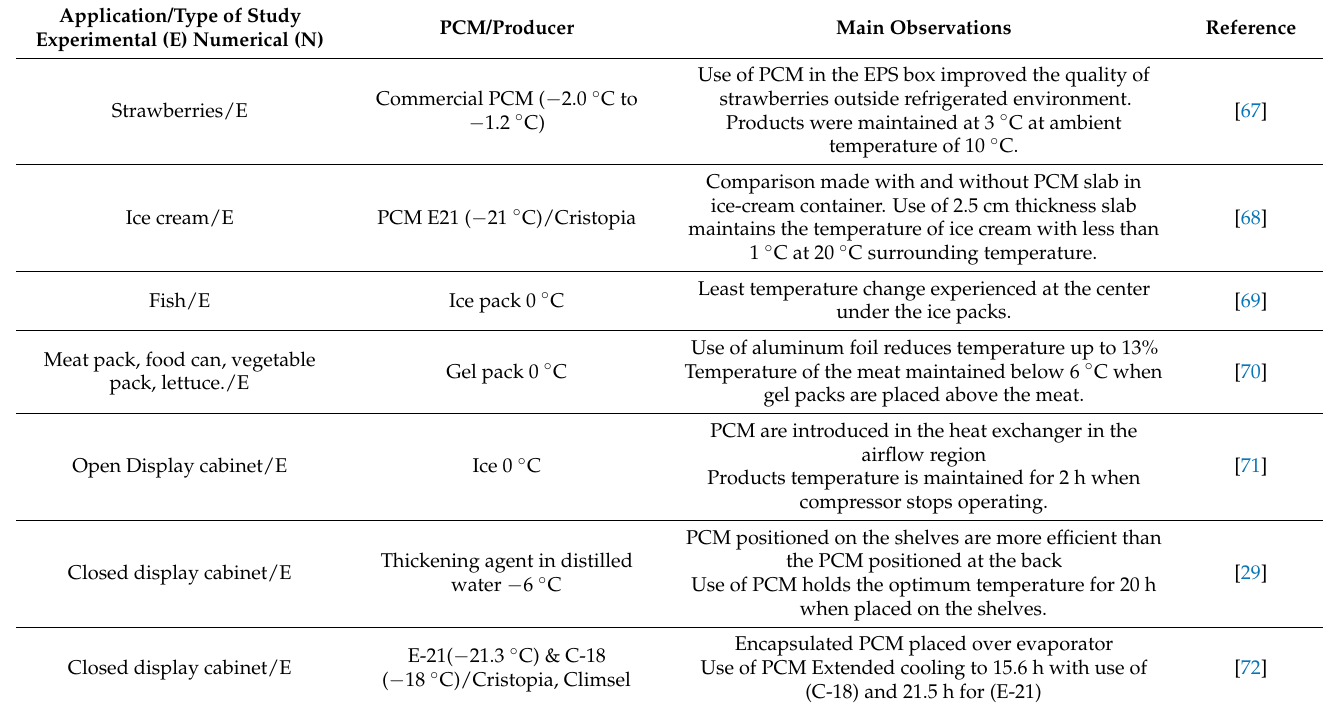
Table 4. Summary of studies reported with the use of PCM in packaging and display cabinets.